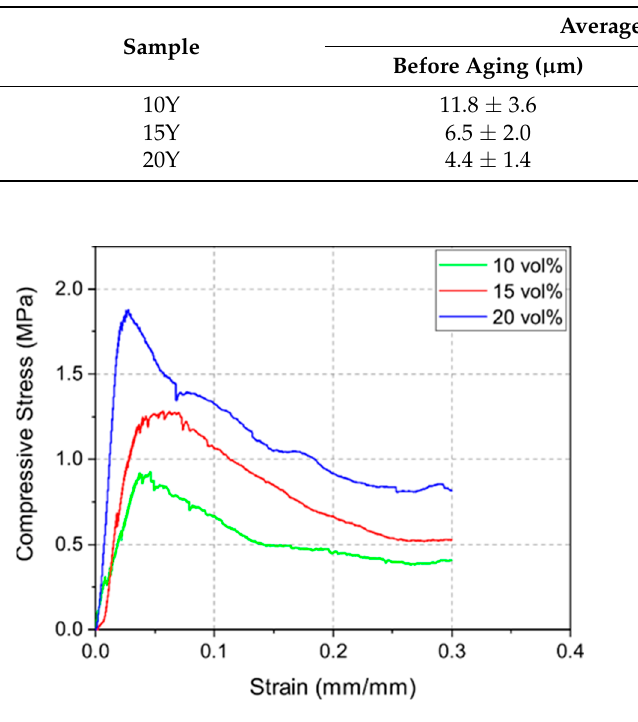
Figure 6. Exemplary stress–strain curves for sintered 10Y, 15Y, and 20Y samples for constant load rate of 1 N s − 1 .